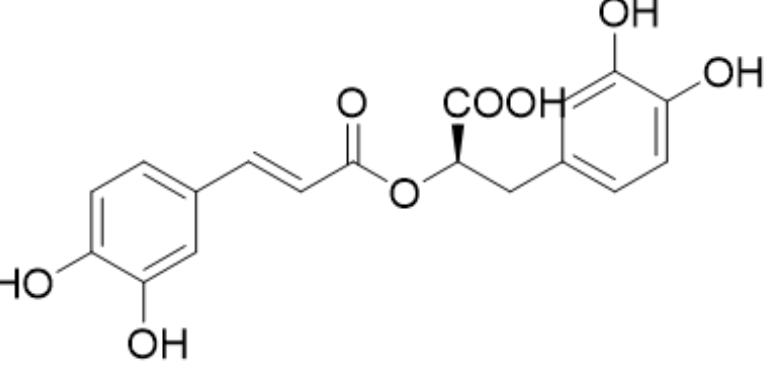
Figure 1. Structure of rosmarinic acid. Origanum dictamnus L., or Cretan dittany, is a perennial and aromatic plant that only grows wild in the mountainsides and gorges of the island of Crete in Greece [10]. The extracts of O. dictamnus have been reported to exert several biological activities, including antioxidant [11–14], antimicrobial against bacteria, protozoans and fungi [15–19], cytotoxic activity against P388 (murineleukemia) and human bronchial epidermoid lung cancer NSCLC-N6 cell lines, respectively [20]. From the polar extracts of the aerial parts of O. dictamnus , monoterpenes, alicyclic derivatives, flavonoids and depsides (salvianolic acid P, rosmarinic acid and rosmarinic acid methyl ester) have been isolated and structurally determined [19]. Recently, a monograph for Dittany of Crete was approved among EU countries registering it as a traditional herbal medicinal product, i.e., herbal tea for oral and cutaneous use (as infusion or decoction)